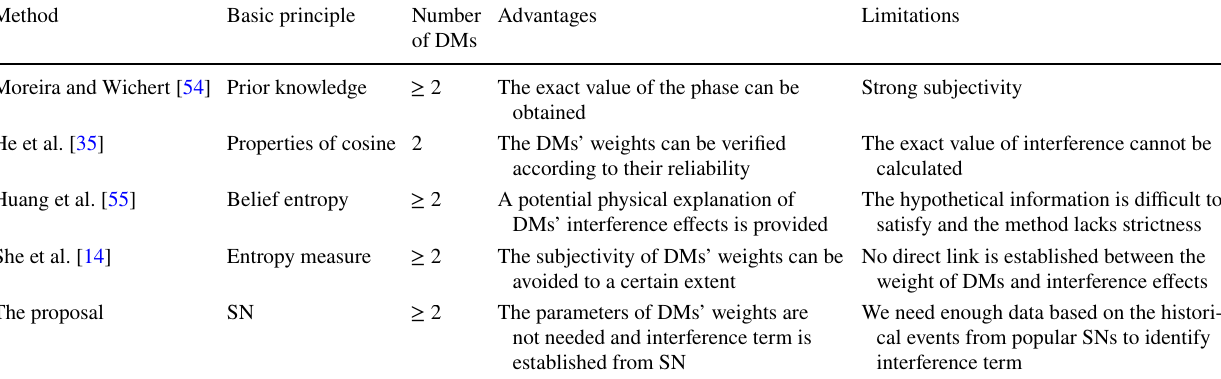
Table 6 The comparison between existing QPT methods and the proposed method